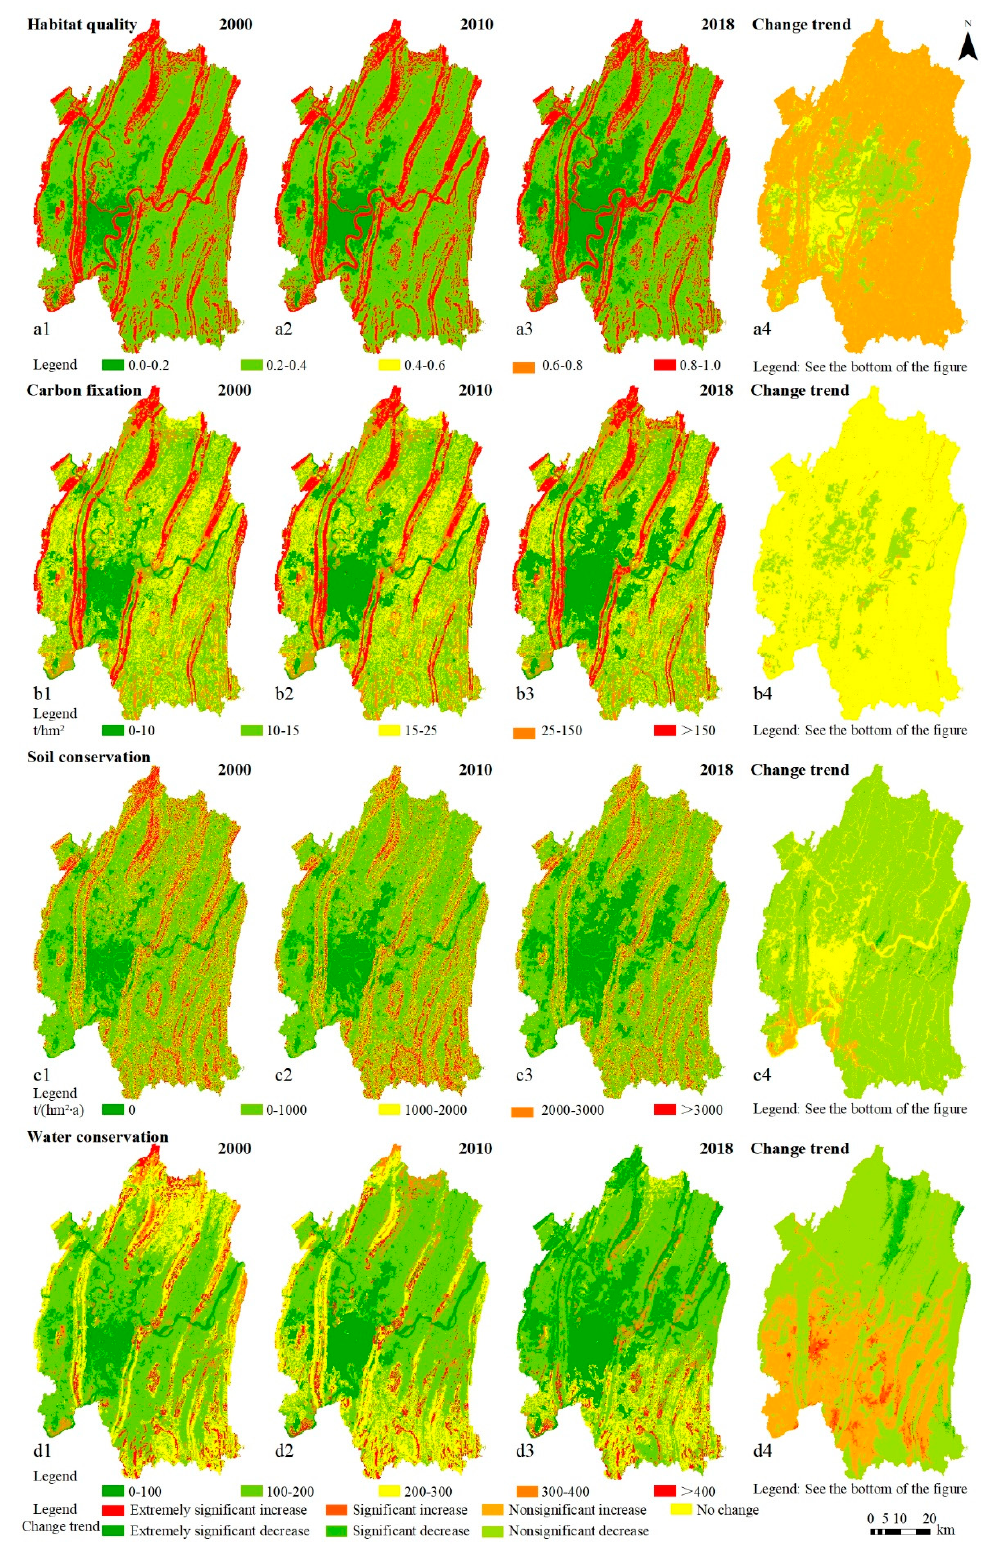
Figure 3. Spatial distributions and change trends of ESs. At the administrative districts scale, Beibei had the highest level of BI, followed by Banan and Yubei (Figure 4a). The highest average values of CF were also detected in Beibei, followed by Shapingba, Jiulongpo and Yubei (Figure 4b). The highest average SC and